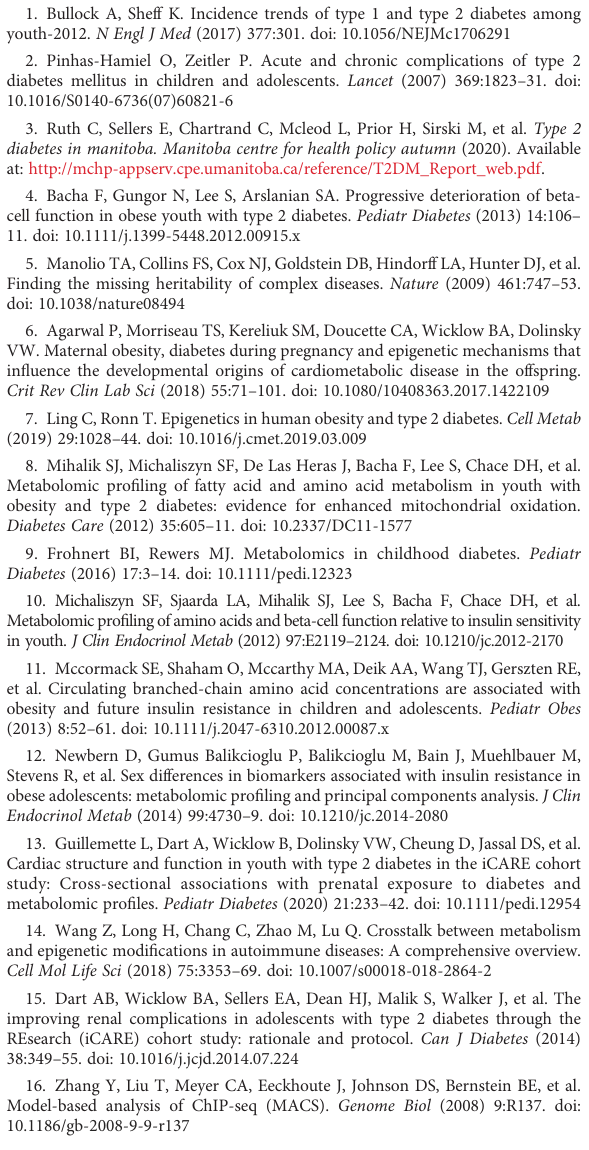
SUPPLEMENTARY TABLE 2 Data integration correlation values. The table contains the correlation values obtained from theDMR and fi ve metabolites integration. The green colored values show the negative correlation and red values show the positive correlation. SUPPLEMENTARY TABLE 3 Information of the DNA methylation sequencing samples. The table provides the information of the samples that were sequenced and submitted in the European Genome-phenome Archive. SUPPLEMENTARY TABLE 4 All the correlated metabolites and